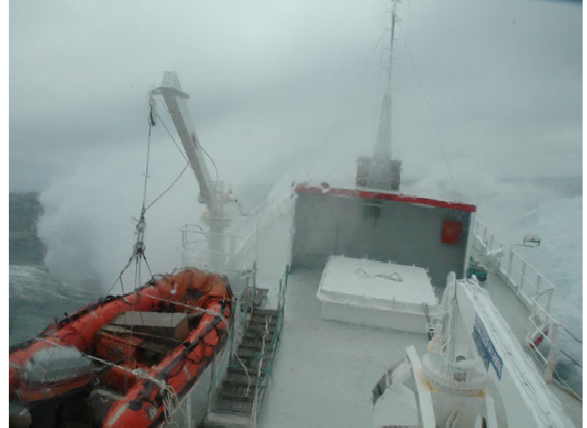
Figure 1. Is that a blow? A bad weather event during a shipboard survey (Photo: SCANS III) Although the definition of “good” weather or acceptable survey conditions (Figure 2) will differ somewhat with the target species of the survey, in NASS surveys, acceptable sea state is mostly taken at Beaufort Sea State <= 4. Clearly larger whales